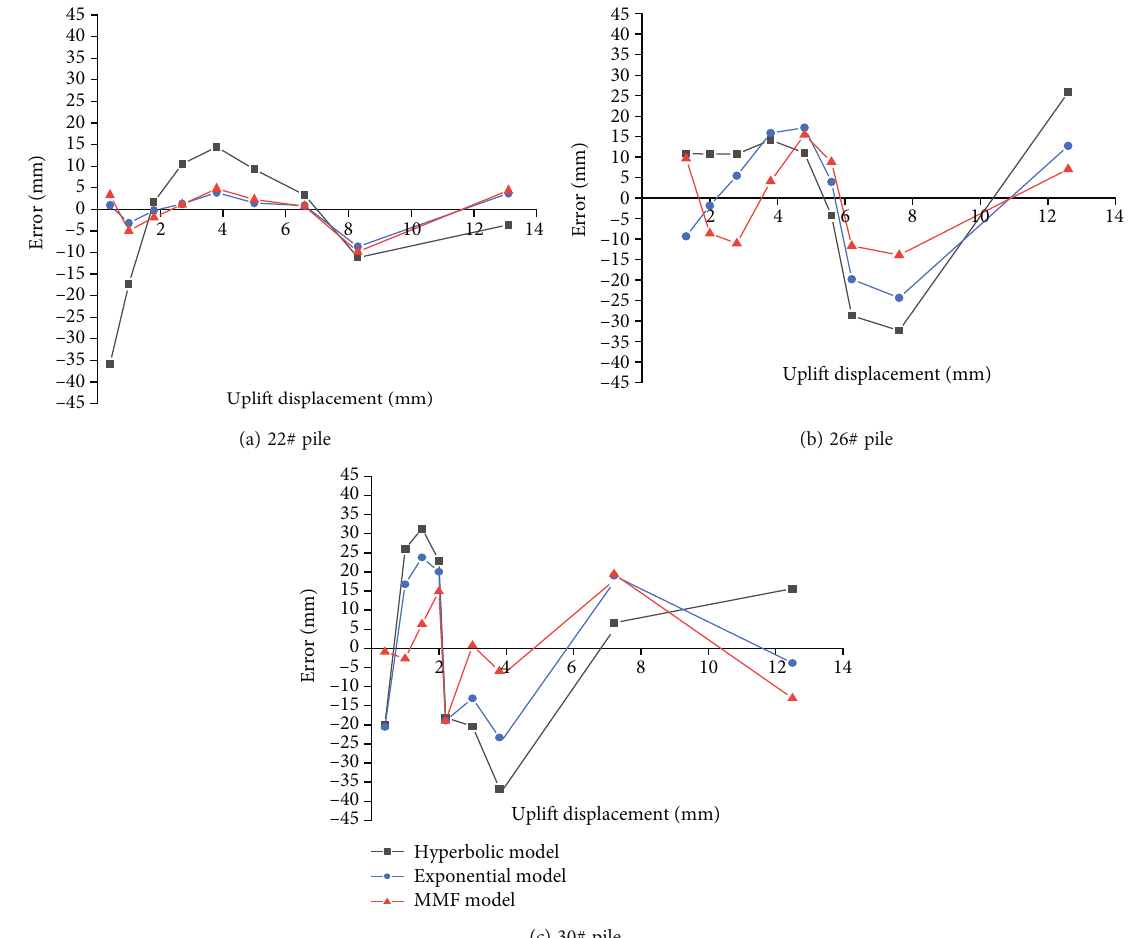
Figure 9: Error comparison chart of MMF model, hyperbolic model, and exponential